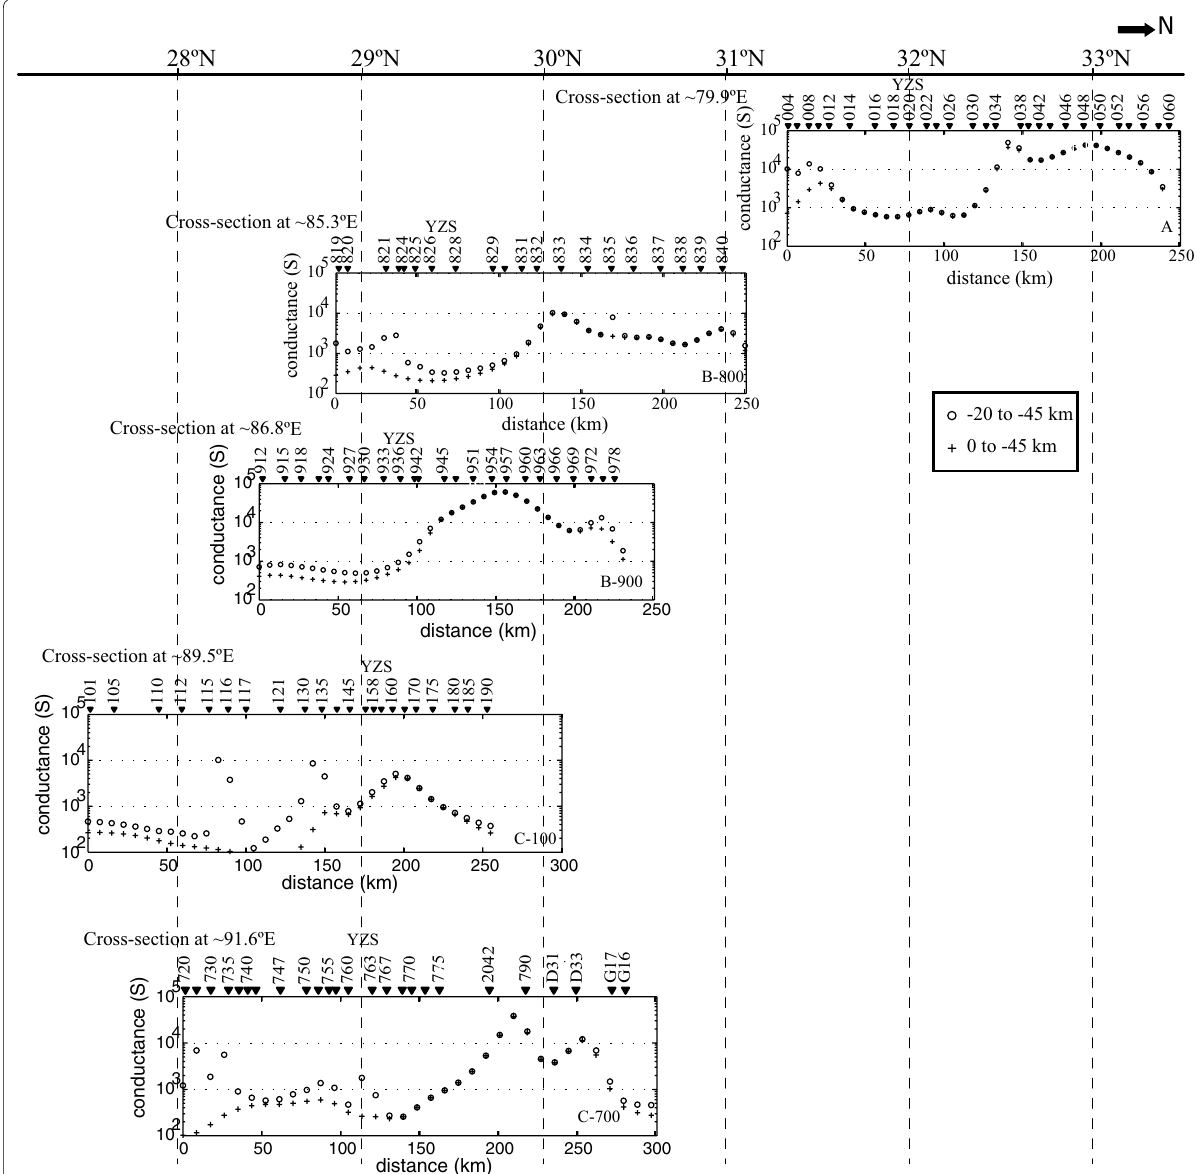
Fig. 10 The conductance cross-sectional maps along different longitudes in southern Tibet. The black circles delineate conductance for depths from 20 to 45 km and the black crosses indicate conductance of depth from 0 to − −